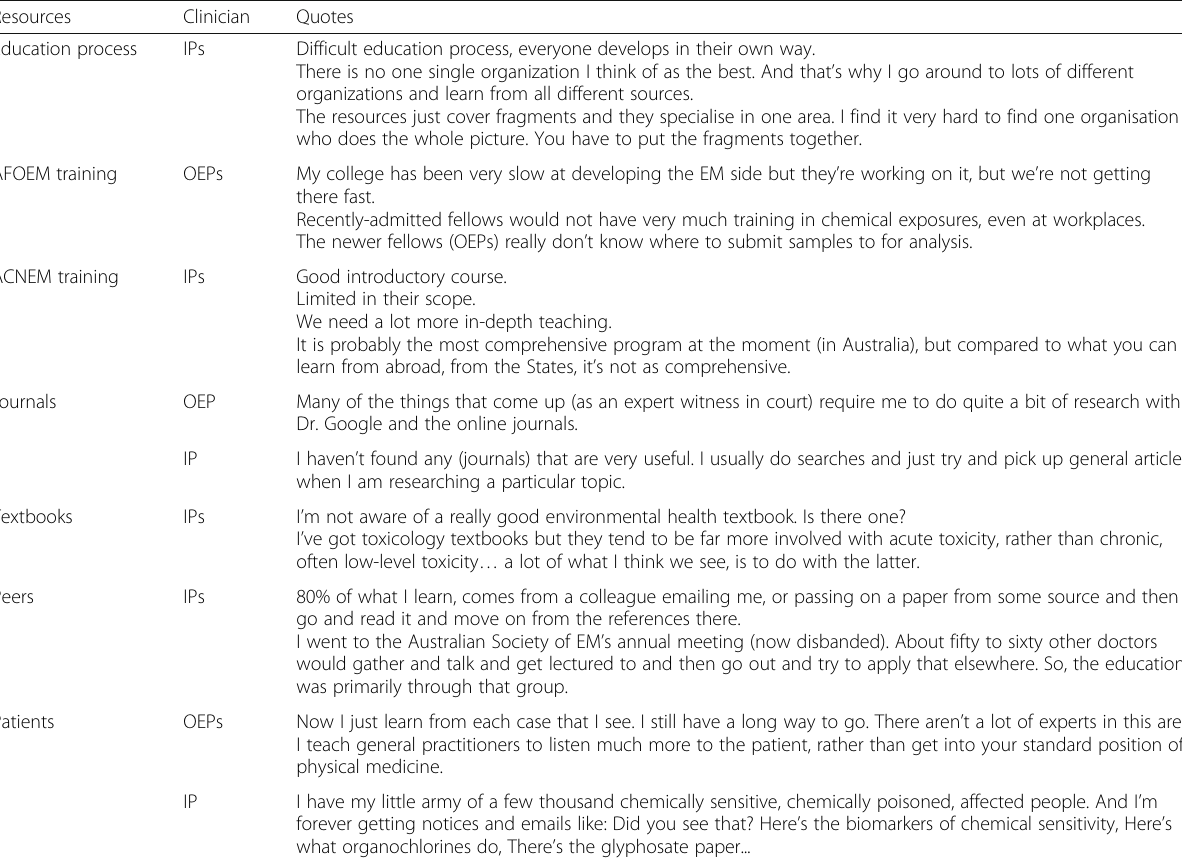
Table 5 Educational and clinical resources in environmental medicine are lacking